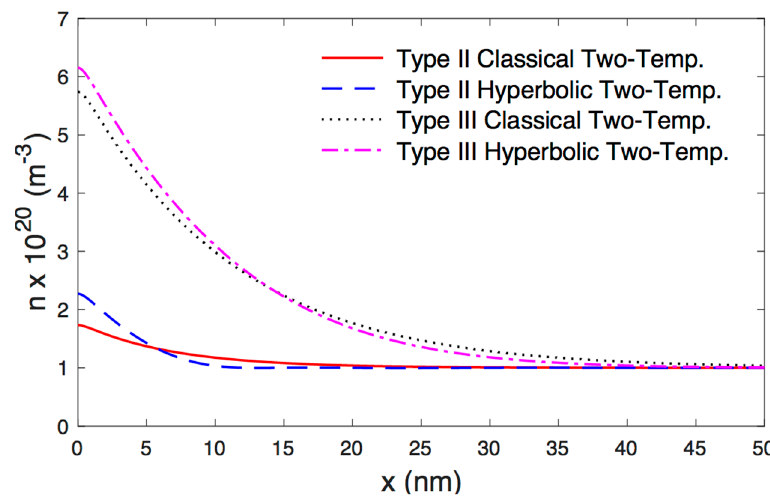
Figure 5. The variation of carrier density with respect to the distance.